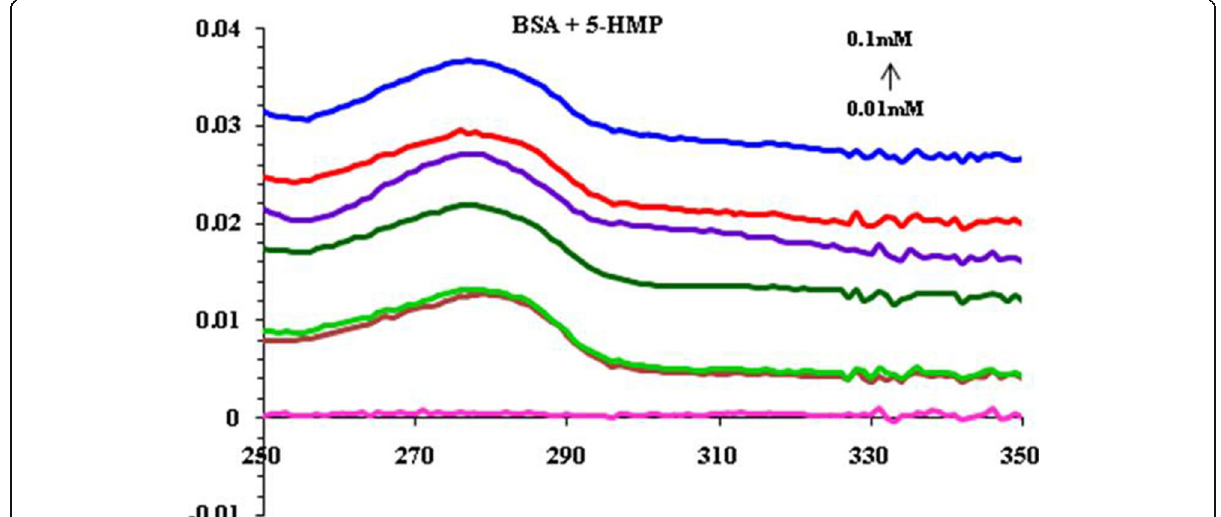
Fig. 8 UV-visible spectroscopic analysis of binding through absorbance between 270 nm to 290 nm on BSA with increase concentration of 5- HMP (0.01, 0.025, 0.05, 0.075, and 0.1